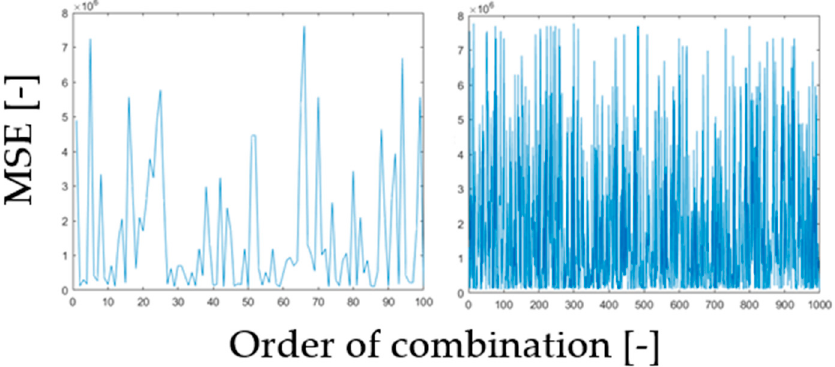
Figure 5. A comparison of MSE evaluation for number of filter parameter’s combinations (n = 100) left and (n = 1000) right for 80 MR records (averaged values for each n).